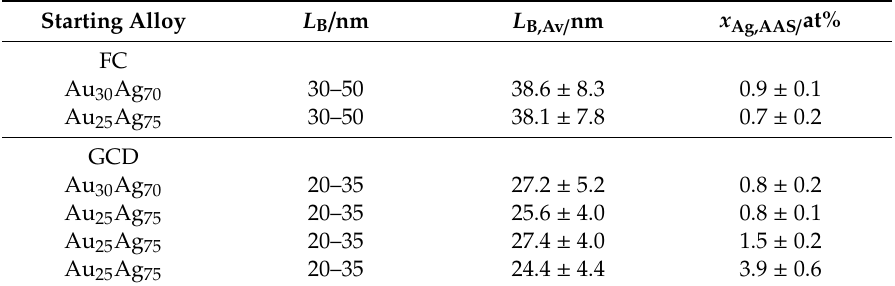
Table 1. Characteristics of npAu samples obtained by FC and GCD and prepared using di ff